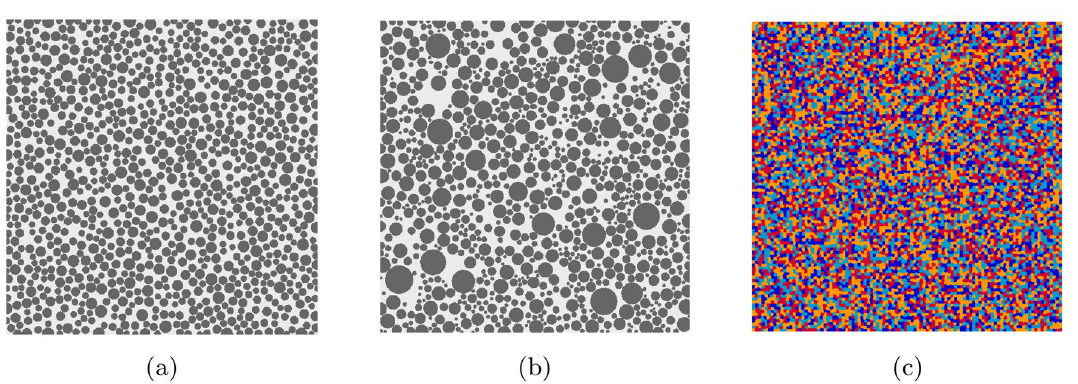
Figure 1. Discretization of a 2D domain: ( a ) generated Voronoi cells, when α f elements using Delaunay Triangulation (blue lines), when α f 0.5 and mesh size is 200 by 200. α f =